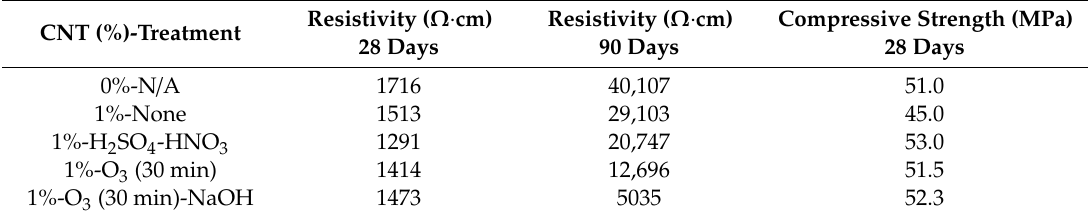
Table 4. The resistivity and mechanical properties of cement pastes with functionalized and non-functionalized CNTs cured for 28 days at 100% RH, and then until 90 days at 60%